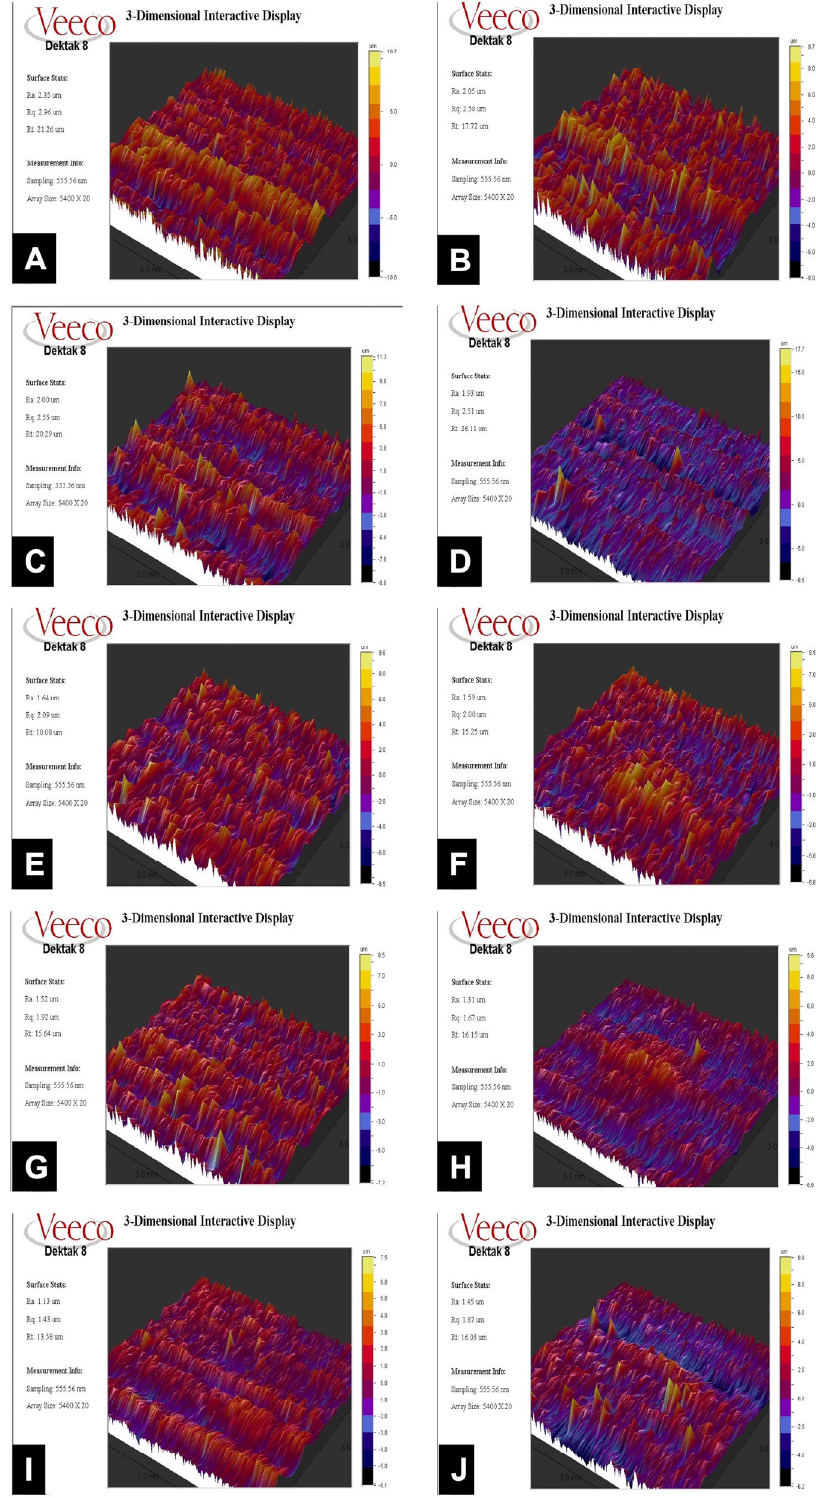
Figure 2. Optic profilometry analysis of various Ti implant surfaces: ( A ) Control untreated, ( B ) Laser, ( C ) Laser + H 2 O 2 , ( D ) Laser + CHX, ( E ) Ti brush, ( F ) Ti brush + H 2 O 2 , ( G ) Ti brush + CHX, ( H ) Ti curette, ( I ) Ti curette + H 2 O 2 , and ( J ) Ti curette + CHX.